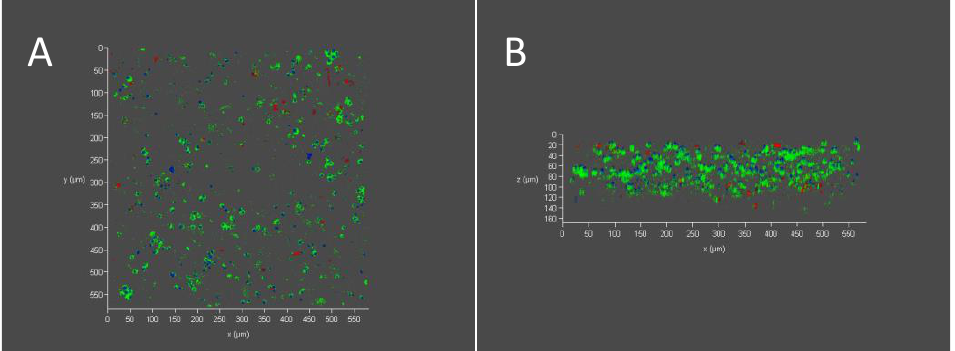
Figure 6. PC12 cell viability and distribution in collagen-GMA hydrogel. Exemplary confocal images show live (green) and dead (red) PC12 cells 48 h after cell seeding in 0.8 wt% collagen-GMA hydrogel (cell nuclei stained blue). High cell viability of 84 ± 2% was observed. ( A ) Viable cells can be seen evenly distributed in the 600 µm× 600 µm section when cells were mixed with collagen-GMA hydrogel-forming solution prior to UV-irradiation. ( B ) Z-stack sections show PC12 cells throughout the 160 µm section.